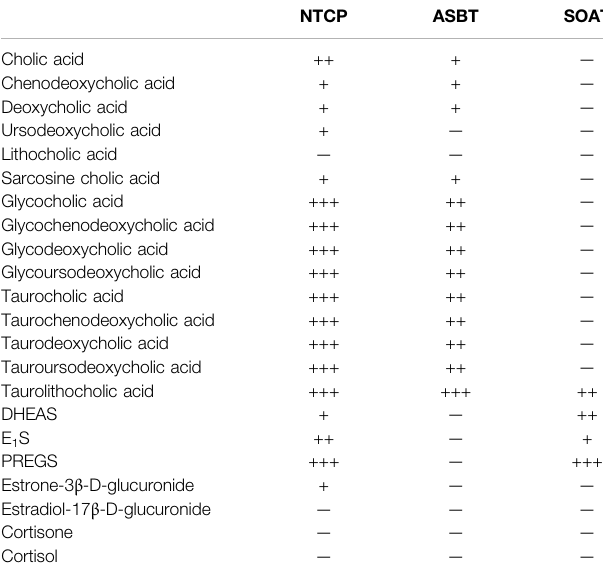
TABLE 1 | Substrate speci fi cities and transport activity grading for NTCP, ASBT andSOAT.Theprimarytransportdataareindicatedin Figure1 .Thefollowing gradingwasused. “—” representsnosigni fi cantuptakecompared tosodium-free control. Mean uptake “ + ” for values below 10, “ ++ ” for values between 10 and 100, and “ +++ ” for values above 100 pmol/mg protein/10 min for sulfated steroidhormones.Meanuptakeofbileacids “ + ” forvaluesbelow500, “ ++ ” for values between 500 and 1000, and “ +++ ” for values above 1000 pmol/mg protein/30